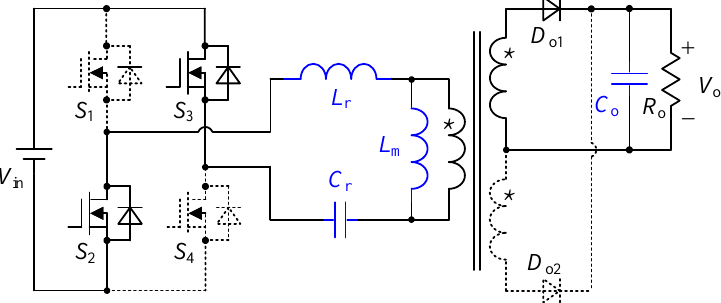
Energies 2020 , 13 , x FOR PEER REVIEW Figure 7. Waveforms of LLC resonant converter above resonant frequency in the ideal case.